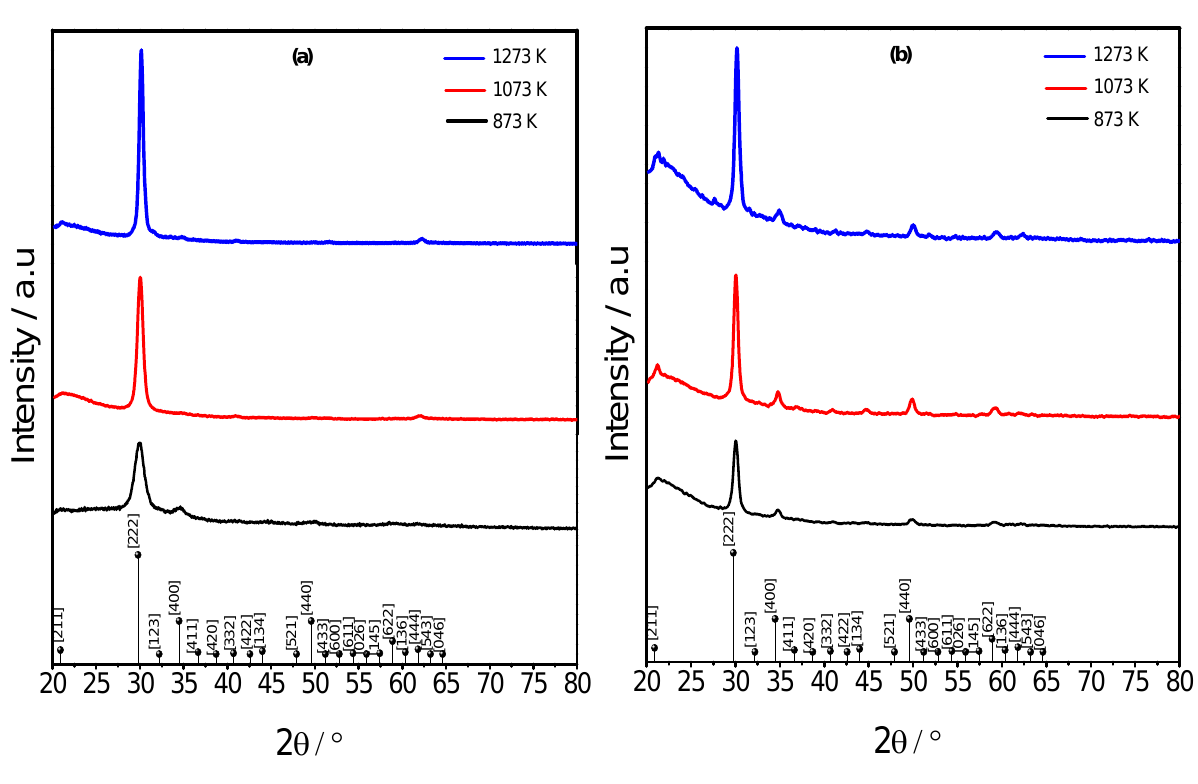
Figure 2. Structural evolution of Lu ( b ) F127/Lu = 2.0.